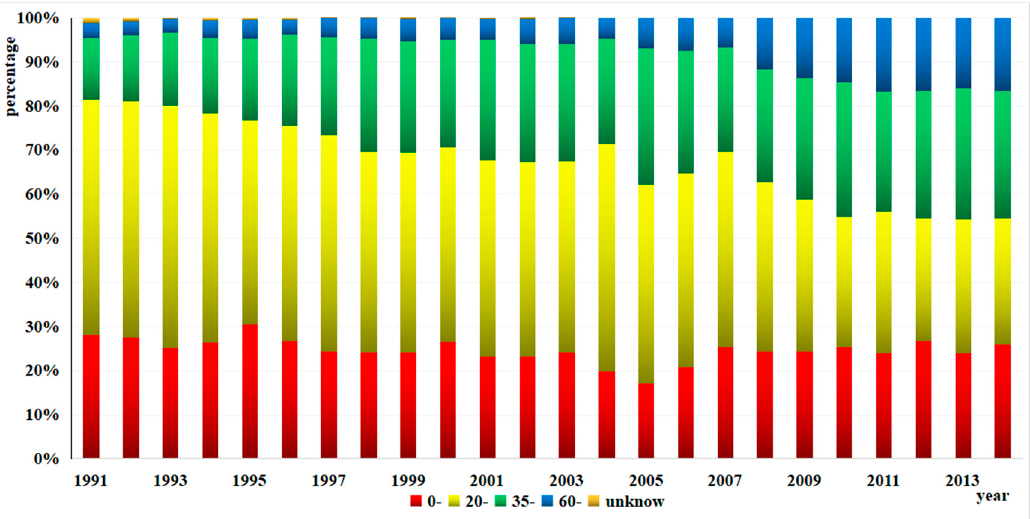
Figure 10. Proportion of the cases in each age group from 1991 to 2014.